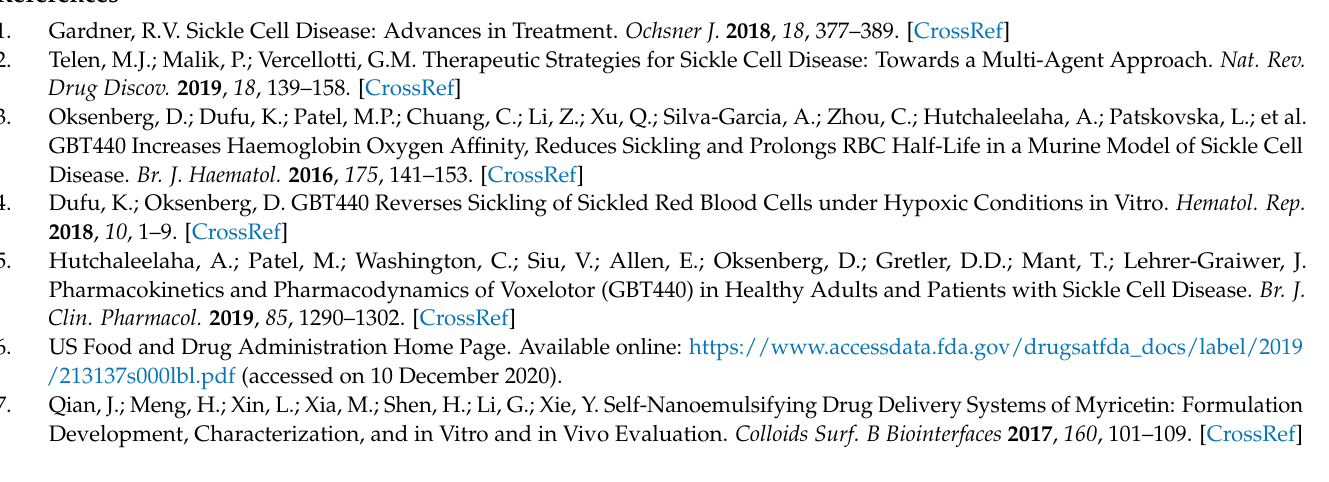
Figure S1. Accuracy profile of HPLC mathod obtained with four concentration levels of voxelotor. The plain line is the relative bias, dashed lines are the β -expectation tolerance limits ( β = 95%) and dotted lines represent the acceptance limits ( ± 20%). The dots represent the relative back-calculated concentrations of the validation standards and are plotted according to their target concentration, Figure S2. Linear profile of HPLC method obtained with four concentration levels of Voxelotor. The plain line is the identity line (y = x), the dashed line is the β -expectation tolerance limits ( β = 95%) and dotted lines represent the acceptance limits ( ±